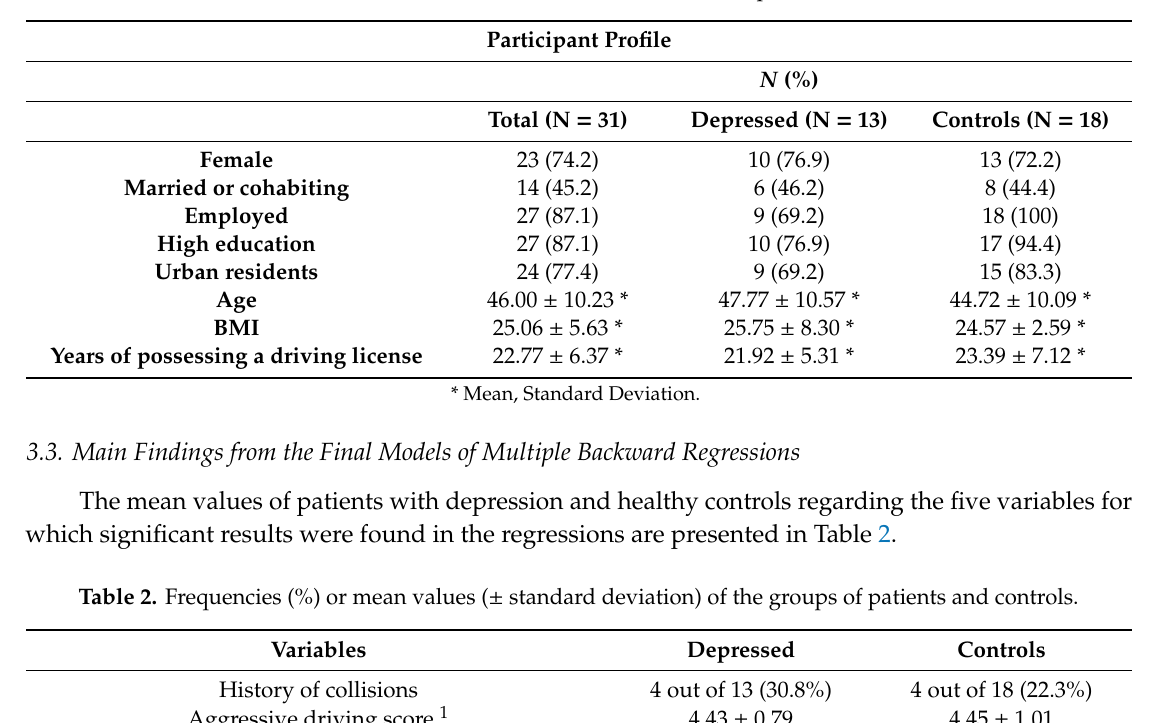
Table 1. Main characteristics of the sample.